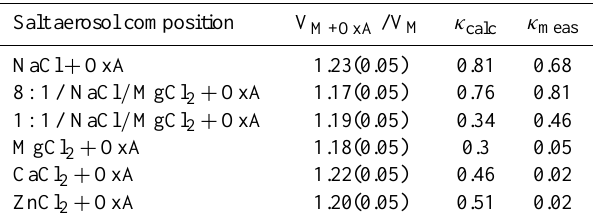
Fig. 3. Critical supersaturation, s c , of divalent salt particles as a function particle diameter. Inorganic salts without OxA deposition are shown by solid lines: ZnCl 2 (gray), CaCl 2 (red), MgCl 2 (green). The corresponding salts with OxA deposition are dashed lines with the same color. Pure OxA and ammonium sulfate are shown in solid magenta, and black lines, respectively. κ values are shown for ZnCl 2 (gray), OxA (magenta), and MgCl 2 + OxA (green). 30 Table 4. Growth factors (V M+OxA /V M ) with uncertainties and κ values for salts and salt mixtures with OxA deposition. Equa- tions (8) and (9) are used to calculate κ calc . Our measured compo- nent κ values are used for the individual components’ κ i , and a GF of 1.2 was